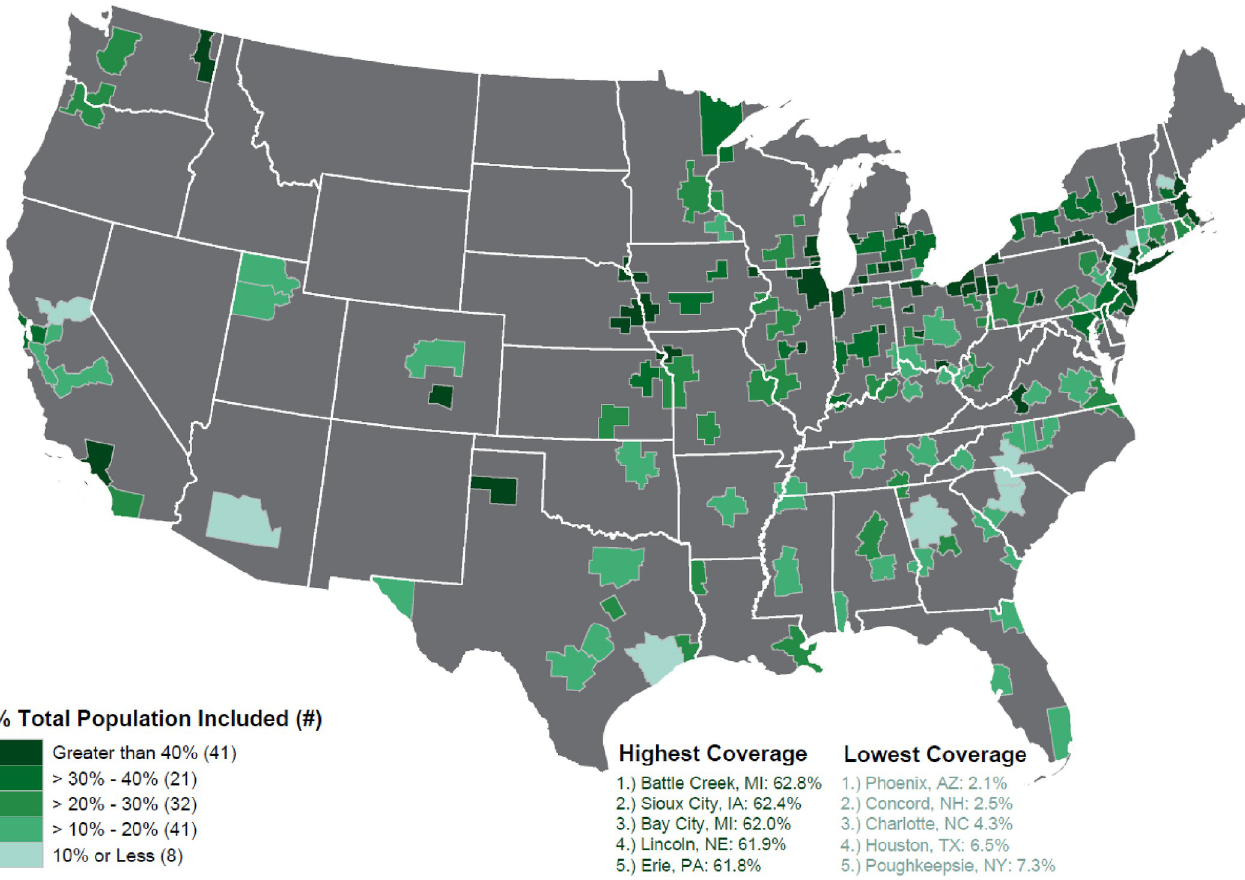
Fig 2. Core based statistical areas. Percentage of population in census tracts with 1% or more HOLC rating coverage. Note: The map image was created using the 2019 TIGER/Line Shapefiles (machine readable data files) / prepared by the U.S. Census Bureau and HOLC rating data published by the Digital Scholarship Lab under a Creative Commons Attribution-NonCommercial-ShareAlike 4.0 International License